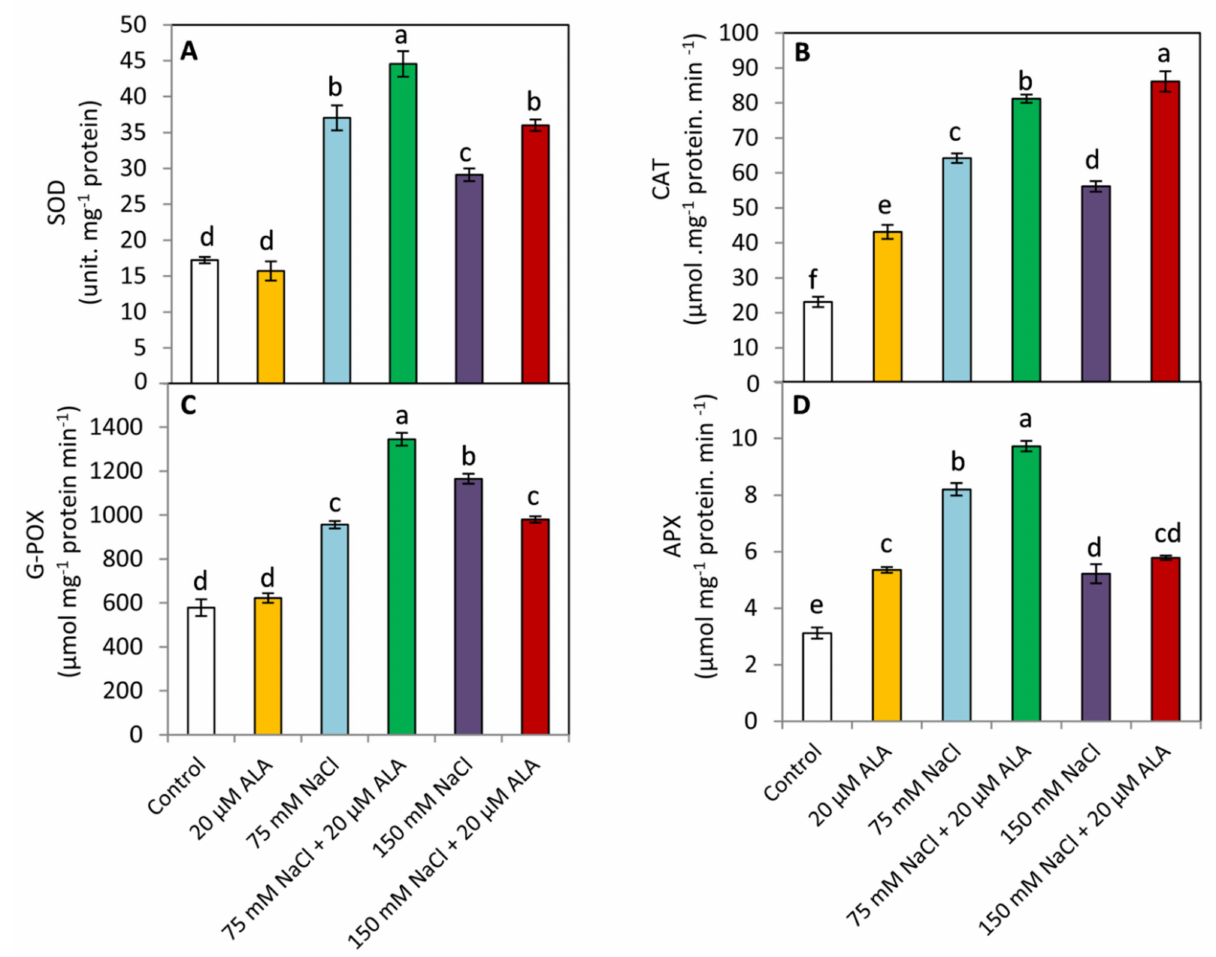
Figure 4. Effect of salinity stress as NaCl (0, 75 and 150 mM) and the foliar application by α -lipoic acid (ALA; 0 and 20 µ M) on the activities of antioxidant enzymes including ( A ) superoxid dismutase (SOD), ( B ) catalase (CAT), ( C ) guaiacol peroxidase (G- POX) and ( D ) ascorpate peroxidase (APX) of sorghum plants. For each parameter, the mean values ± SD followed by a different letter are significantly ( p ≤ 0.05) different according to Tukey’s range